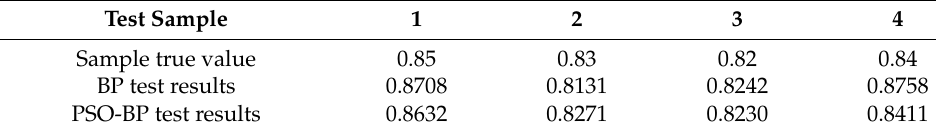
Table 9. Comparison of the predicted values of the four test sets. Test